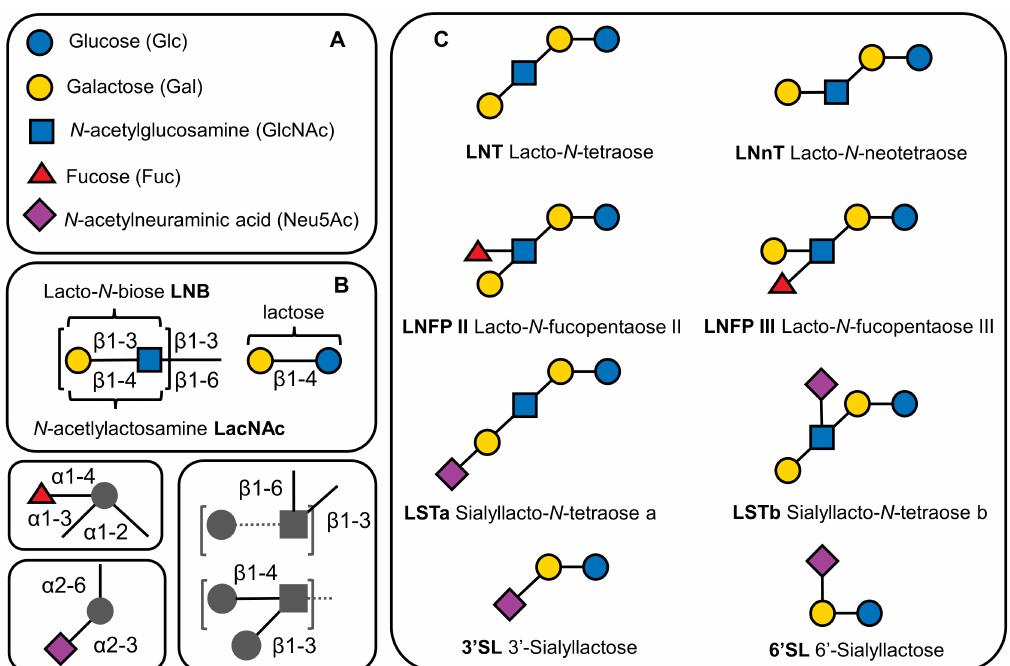
Figure 1. Schematic representation of HMOs. ( A ) The monosaccharide building blocks of HMOs using the symbol nomenclature for glycans (SNFG) [6]. ( B ) General HMO structure, chain elongation possibilities, and the site and modification types of the HMO backbone with Fuc and/or Neu5Ac. ( C ) The structures of the investigated isomeric HMO